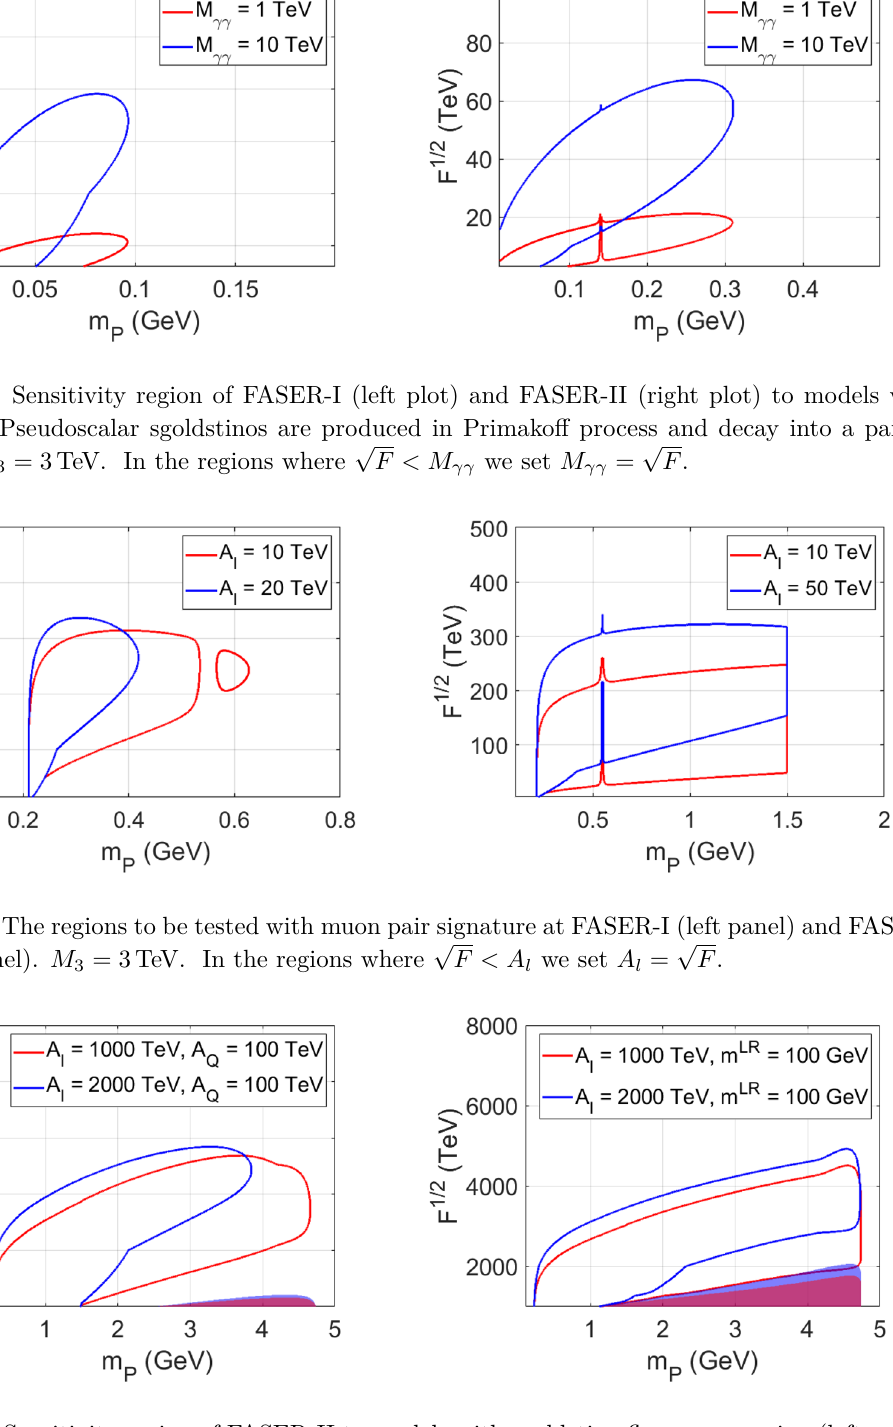
√ √ F < A l we set A l = F